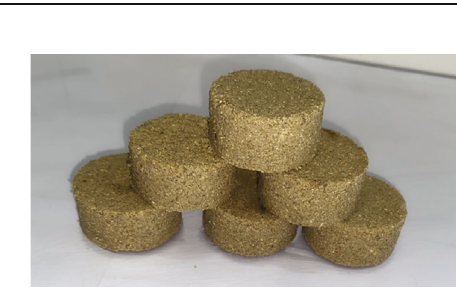
Figure 1: The prepared ice-rich frozen sandy soil